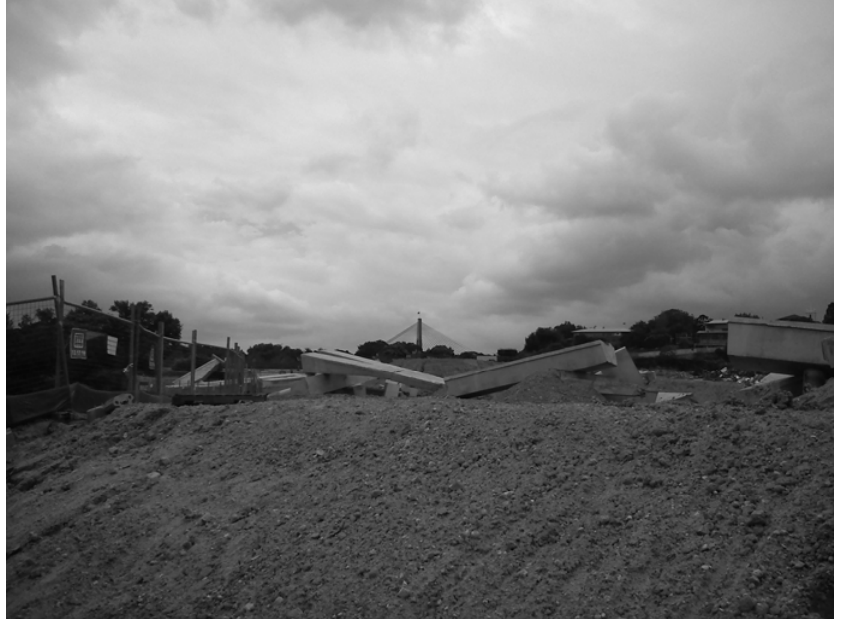
Figure 5. Rubble from demolitions, Sydney